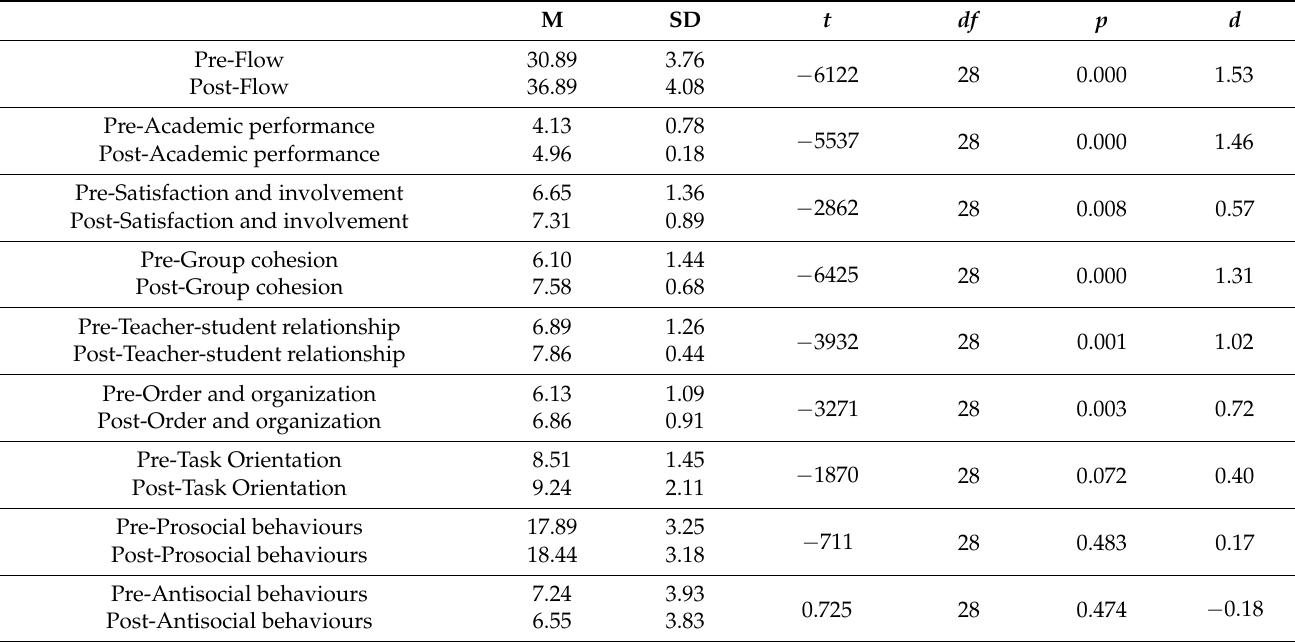
Table 1. Pre-test and post-test differences between the experimental group. M SD